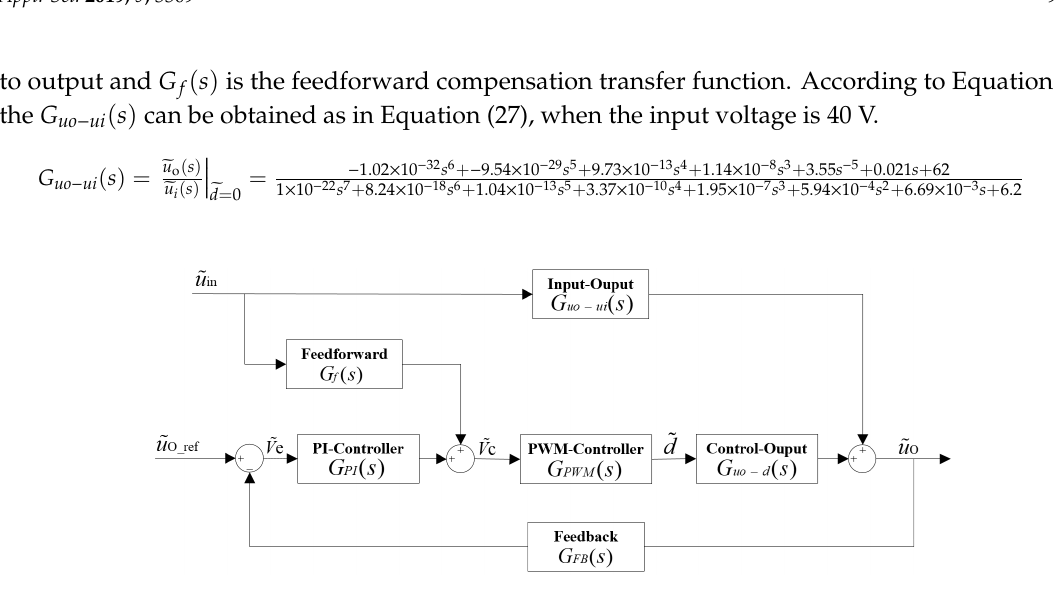
Figure 5. Block diagram of feedforward compensation and the feedback control system.